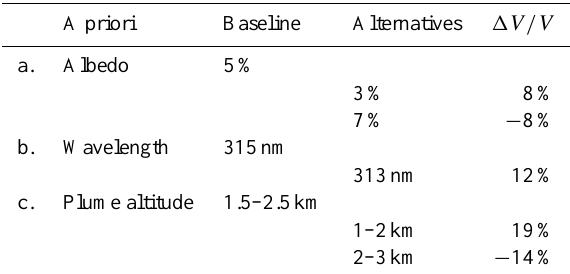
Table 1. Baseline and alternative a priori settings for the calculation of AMFs and their impact on monthly mean VCD V for March– November 2008.